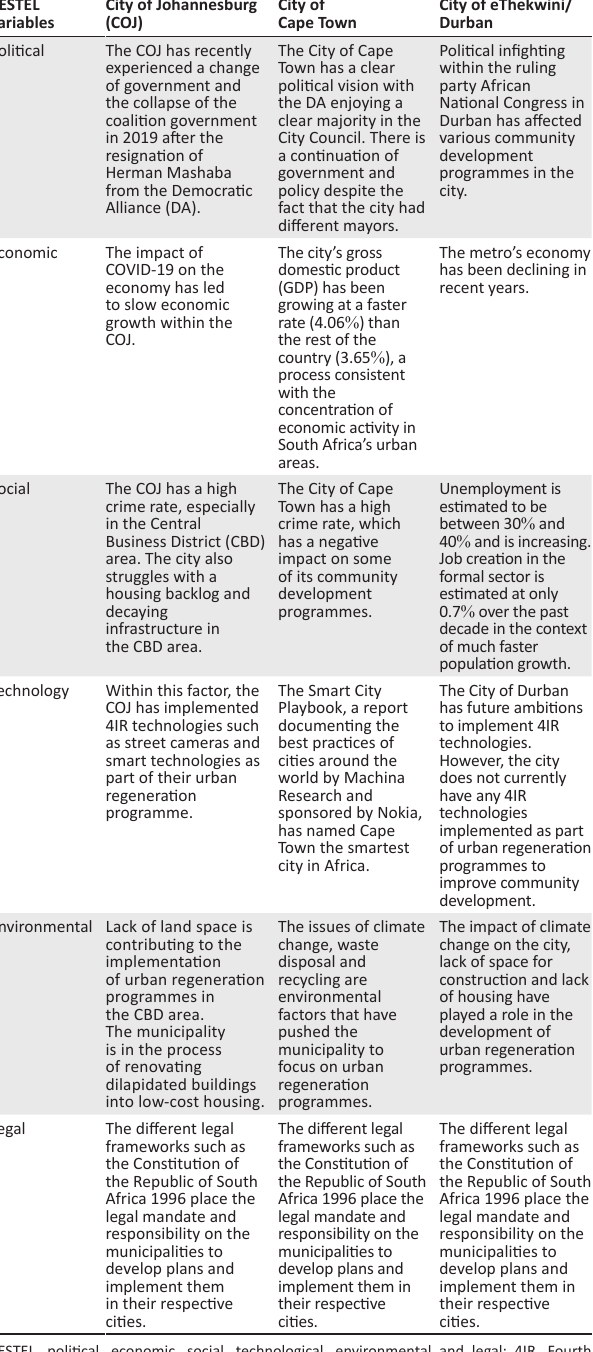
TABLE 1: The influence of PESTEL factors on urban regeneration in South African Metropolitan Municipalities. PESTEL